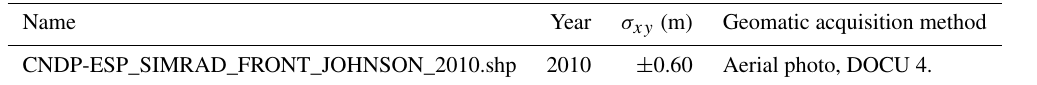
Table 4. ARCGIS shape file corresponding to the satellite image of QUICKBIRD system program (2010). The image is corrected to sea level to obtain the correct planimetric position of Johnsons Glacier calving front. In the third column the RMS error is shown.